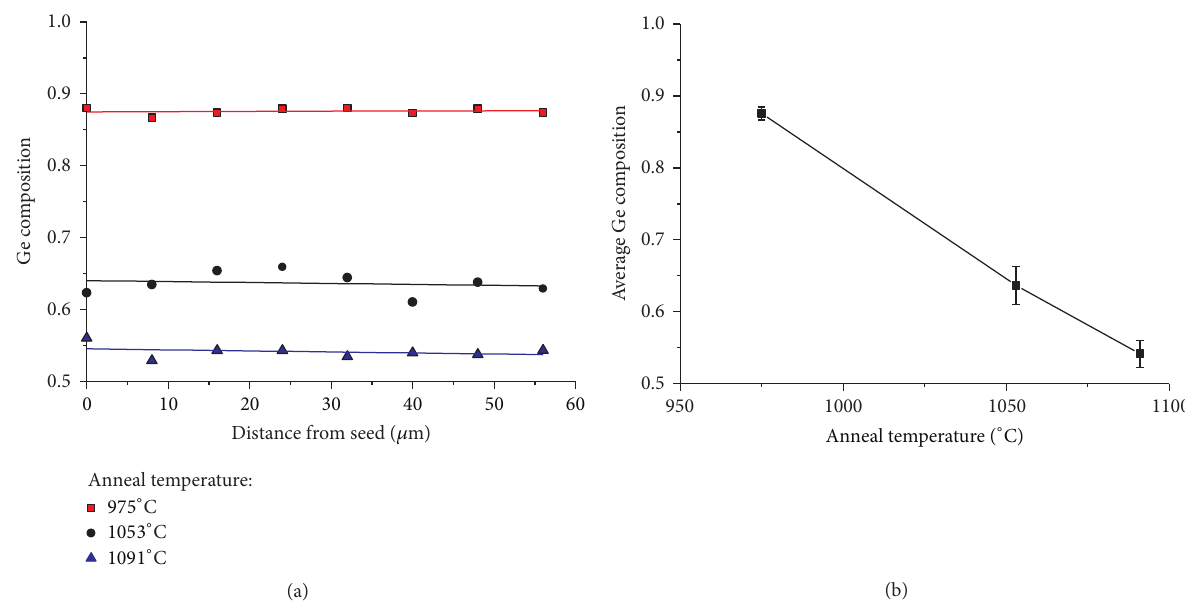
Figure 12: SiGe composition tuning by varying the RMG annealing temperature. (a) Composition profiles in the central strips of tailored tree-like structures annealed at a range of temperatures. A linear fit has been added to each data set and (b) average Ge composition along the central strip of a tailored tree-like structure as a function of annealing temperature. Only the uniform region up to 56 𝜇 m has been considered. The error bars show the maximum and minimum values observed along each strip. C = 3 𝜇